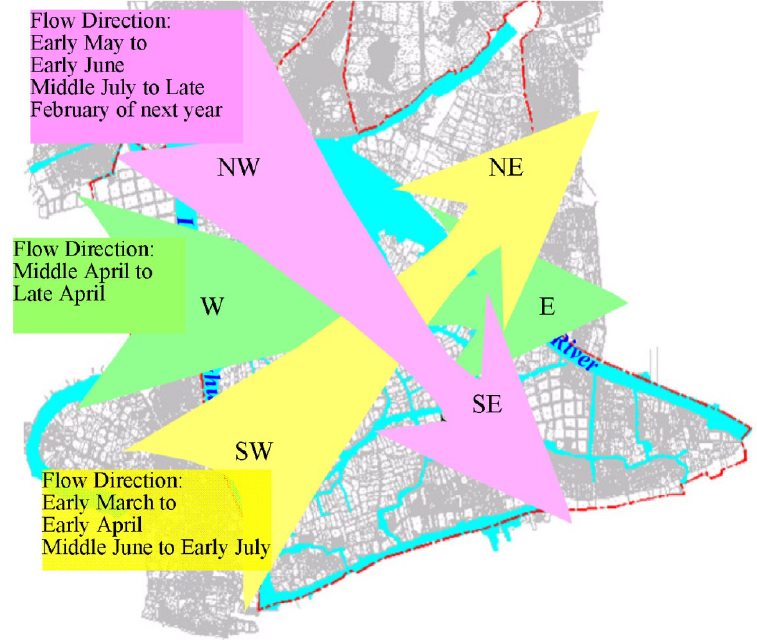
Figure 4. Main flow directions in a year.